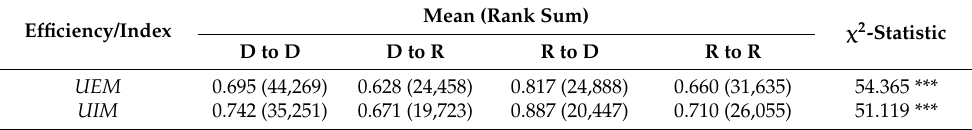
Table 9. Kruskal-Wallis Tests of States with Different Gubernatorial Election Results.